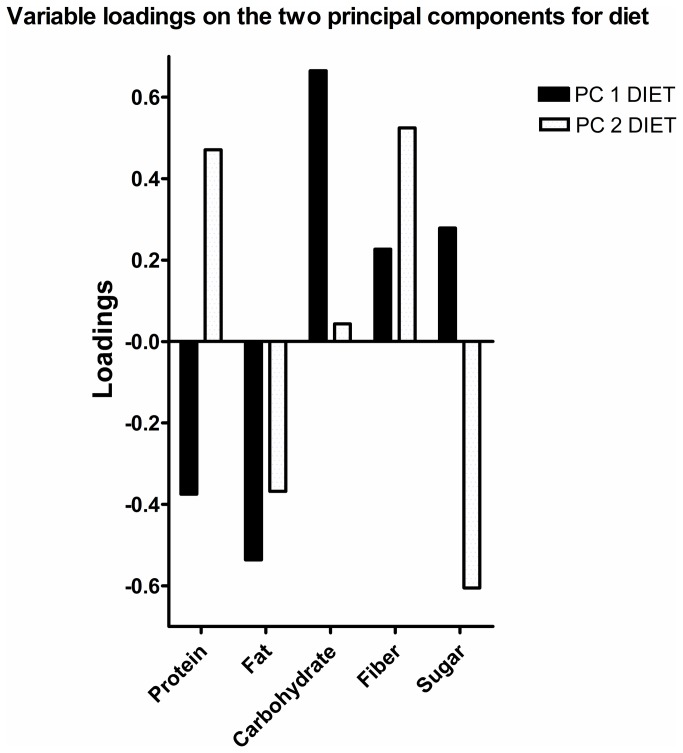
Variable loadings on the two principal components for diet.A higher score on PC 1 DIET indicates that a subject consume (mainly) more carbohydrate and less fat, whereas a higher score on PC 2 DIET indicates that a subject consume (mainly) less sugar and more fiber.